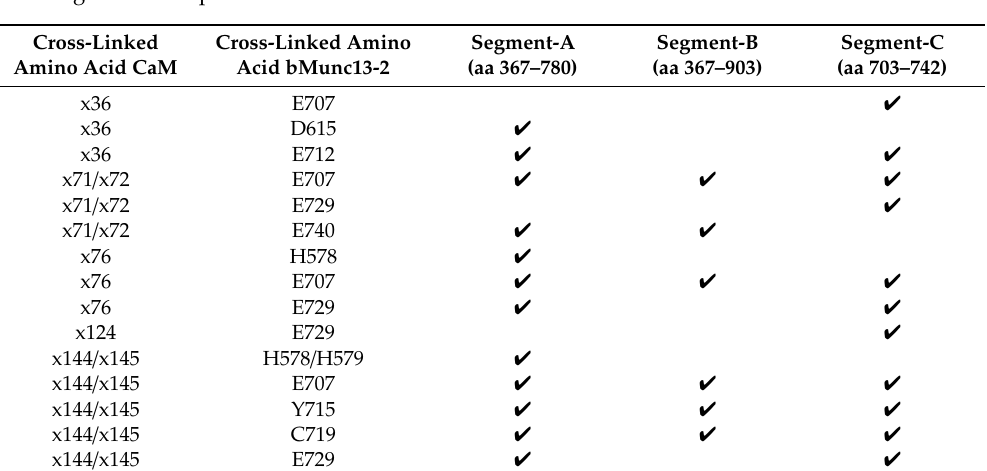
Table 2. Comparison of intermolecular cross-links identified between CaM and bMunc13-2 segments. The constraints derived from the cross-links with segment-A and segment-B were used for structural modeling. x denotes